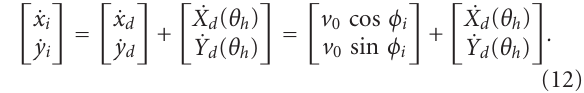
where PP i is the vector from the center of mass of the rover to one of the wheels with the equivalent index. Both